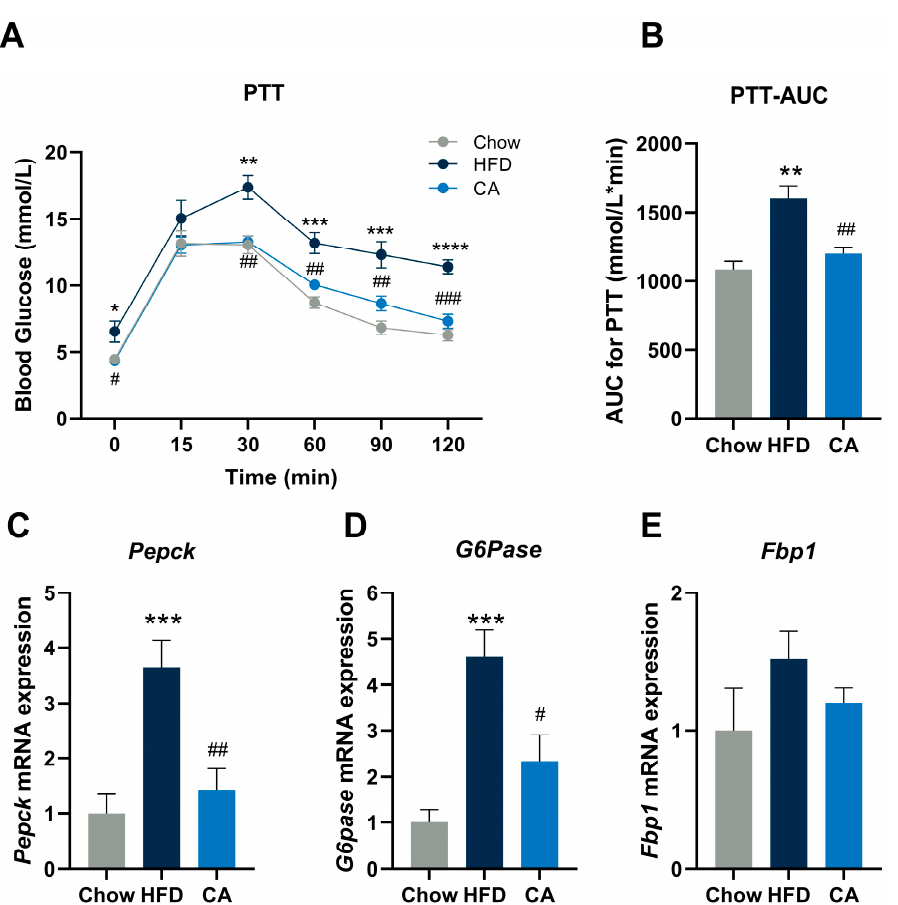
Figure 4. CA inhibits hepatic gluconeogenesis. ( A , B ) Pyruvate tolerance test (PTT) and its AUC. Data are expressed as means ± SEM ( n = 6). ( C – E ) mRNA expression of genes involved in gluconeogenesis in the livers of mice ( n = 6). Pepck , phosphoenolpyruvate carboxykinase; G6Pase, glucose-6-phosphatase, catalytic subunit; and Fbp1 , fructose-1,6-bisphosphatase 1. * p < 0.05 vs. Chow group, ** p < 0.01 vs. Chow group, *** p < 0.001 vs. Chow group, **** p < 0.0001 vs. Chow group, # p < 0.05 vs. HFD group, ## p < 0.01 vs. HFD group, ### p < 0.001 vs. HFD group.